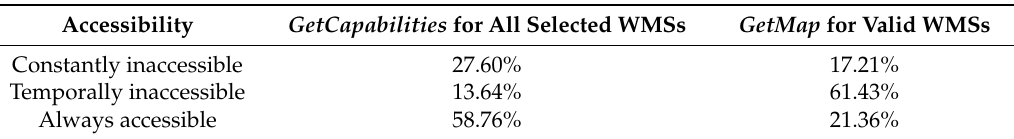
Figure 11. Successability histograms of the two mandatory operations for valid WMSs: ( a ) GetCapabilities ; ( b ) GetMap . Table 4. Accessibility of GetCapabilities and GetMap